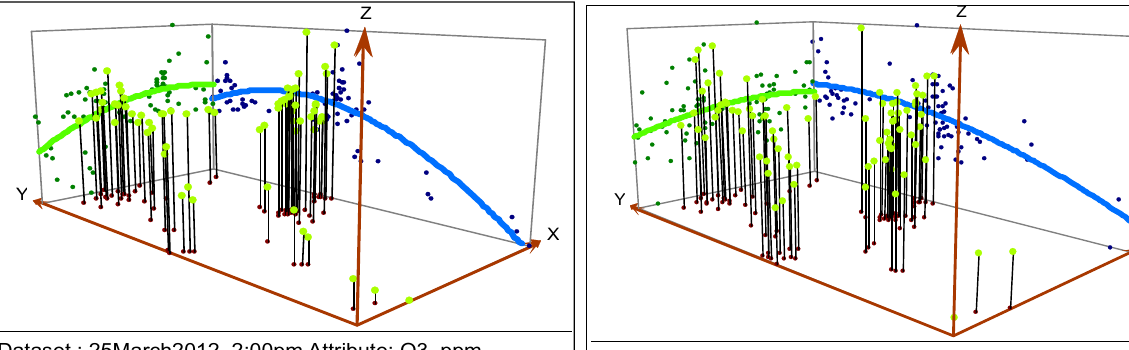
Figure 4. Representation of O